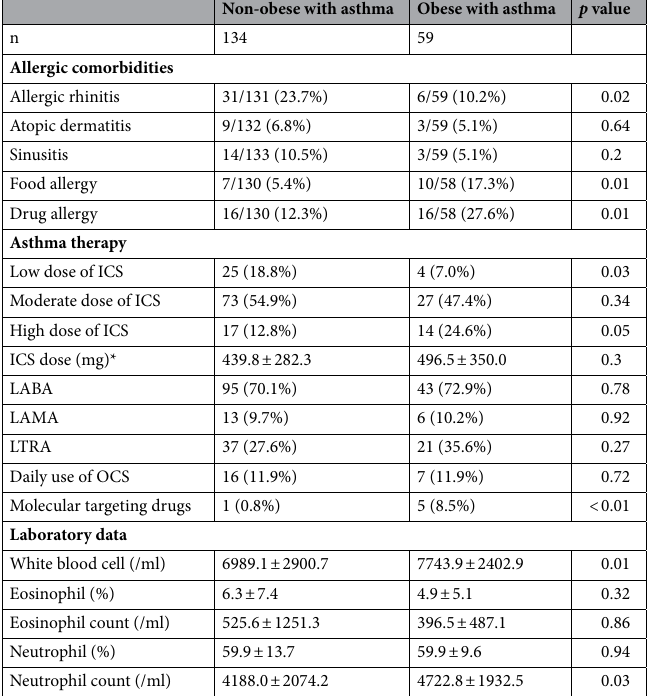
acting muscarinic antagonist; LTRA, leukotriene receptor antagonist; OCS: oral corticosteroid. *The dose was calculated by beclomethasone